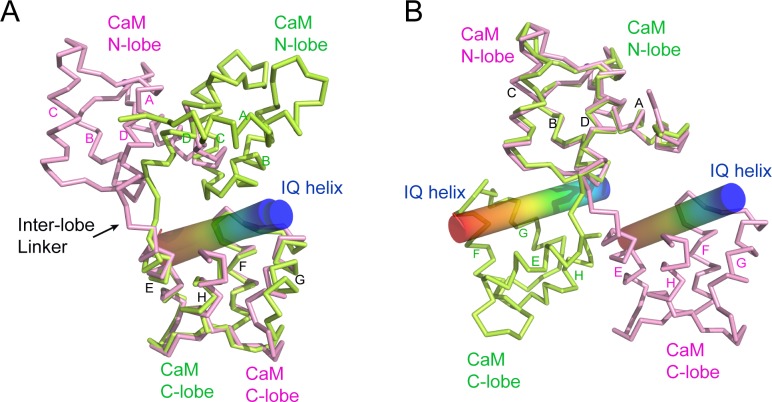
CaM adopts a unique conformation in the SidJ–CaM complex.(A) Structural comparison of CaM (pink) bound to SidJ IQ helix with that (green) bound to myosin V IQ1 (PDB ID: 2IX7). IQ helixes are displayed as cylinders colored in a spectrum from blue to red from the N-terminal to C-terminal ends, respectively. CaM structures are aligned respective to their C-lobes. (B) Structural overlay of the same two structures shown in panel (A) with CaM structure aligned with reference to their N-lobes.